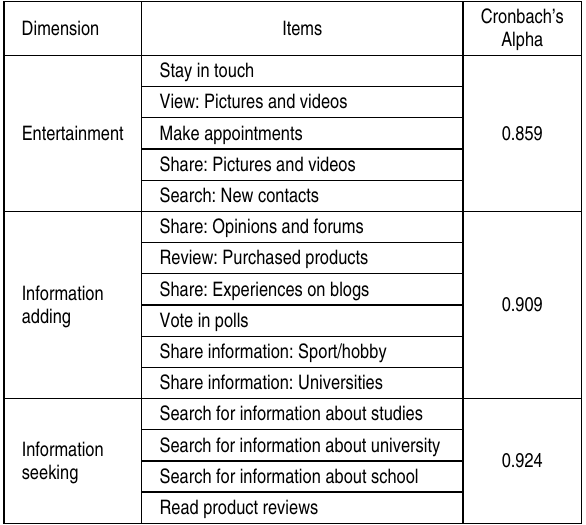
Table 2. Reliability assessment results for social